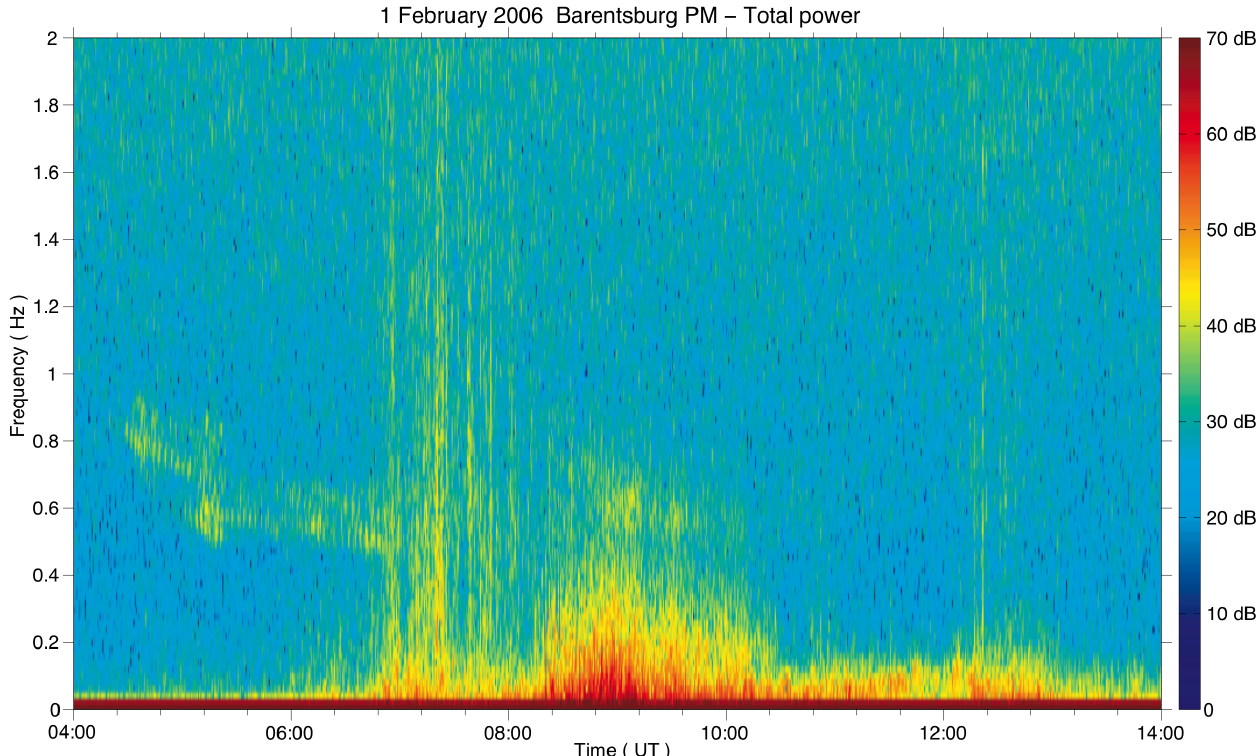
Fig. 8. Sonogram produced from the Barentsburg pulsation magnetometer. Pc-1 (0.2–0.5Hz) and Pc-3 (22–100mHz) are observed. Around our time of interest (09:27UT), a faint activity is seen around 0.6Hz.